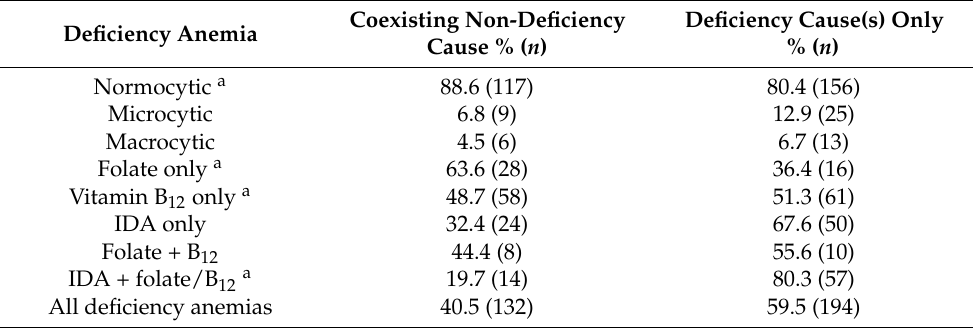
Table 4. Deficiency anemias and coexisting non-deficiency anemia causes (classified according to receiver operating characteristic analysis) in the PolSenior